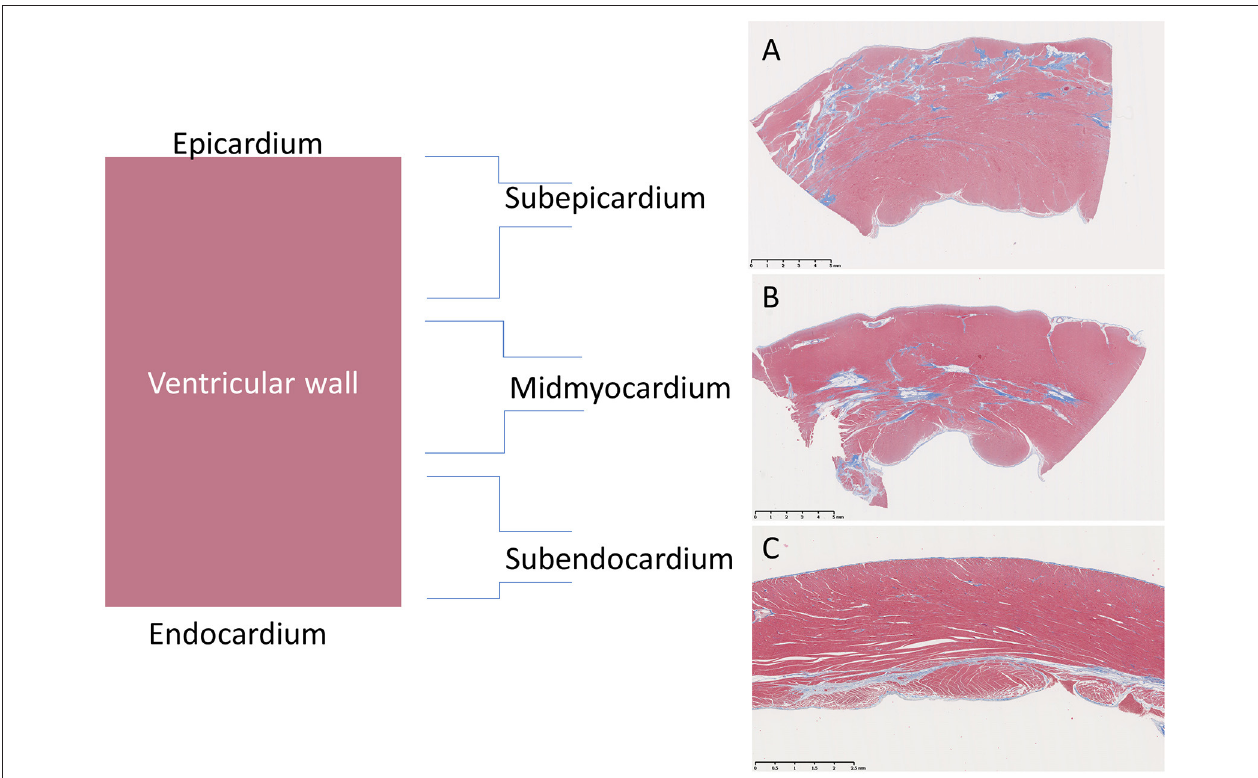
FIGURE 2 | Representation of distributions of fibrotic lesions within the ventricular wall of Golden Retriever muscular dystrophy (GRMD) dogs using a trichrome stain which stains collagen blue and muscle fibers red. (A) The sub-epicardial myocardium (male, 3-years-old) is reportedly preferentially affected in GRMD dogs (pictured) and Duchenne muscular dystrophy boys (not pictured). (B) However, the mid-myocardium (male, 4-years-old) may predominate. (C) Subendocardial changes were rare and only seen in the right ventricle (female,